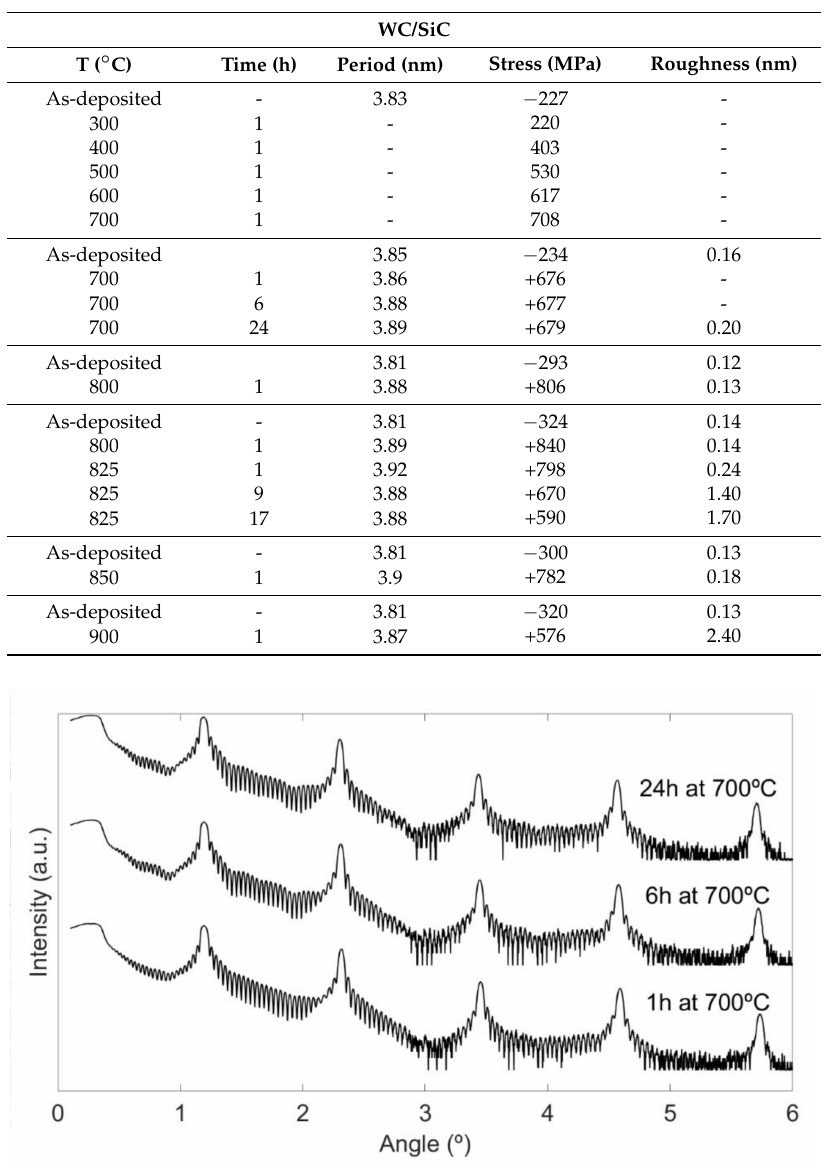
Figure 3. SAXRD spectra of a short (~3.8 nm) period WC/SiC after being annealed at 700 ◦ C for 1 h, 6 h, and 24 h. This multilayer consists of 30